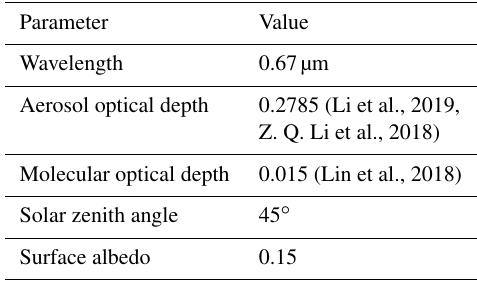
Table 1. Input parameters for radiative transfer